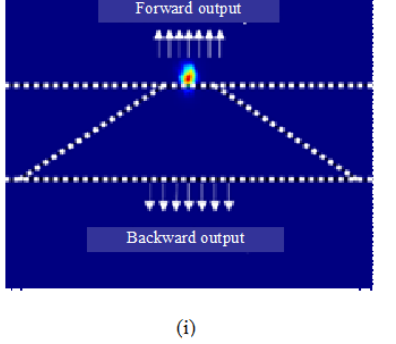
Fig. 6 Electric field intensity received at the base of the NFS as a percentage of power transmitted from a dipole from the NFS with different D B / W B : (a) with conical morphology ( λ = 637 nm), (b) with pyramidal morphology ( λ = 637 nm), (c) with conical morphology ( λ = 532 nm), (d) with pyramidal morphology ( λ = 532 nm); contour maps showing the relationship of electric field intensity, received at the base of the NFS, with a dipole distance from the NFS and D B / W B of the NFS: (e) with conical morphology ( λ = 637 nm), (f) with pyramidal morphology ( λ = 637 nm), (g) with conical morphology ( λ = 532 nm), (h) with pyramidal morphology ( λ = 532 nm); (i) electric field profile of the dipole showing the simulation setup and the mechanism of receiving the